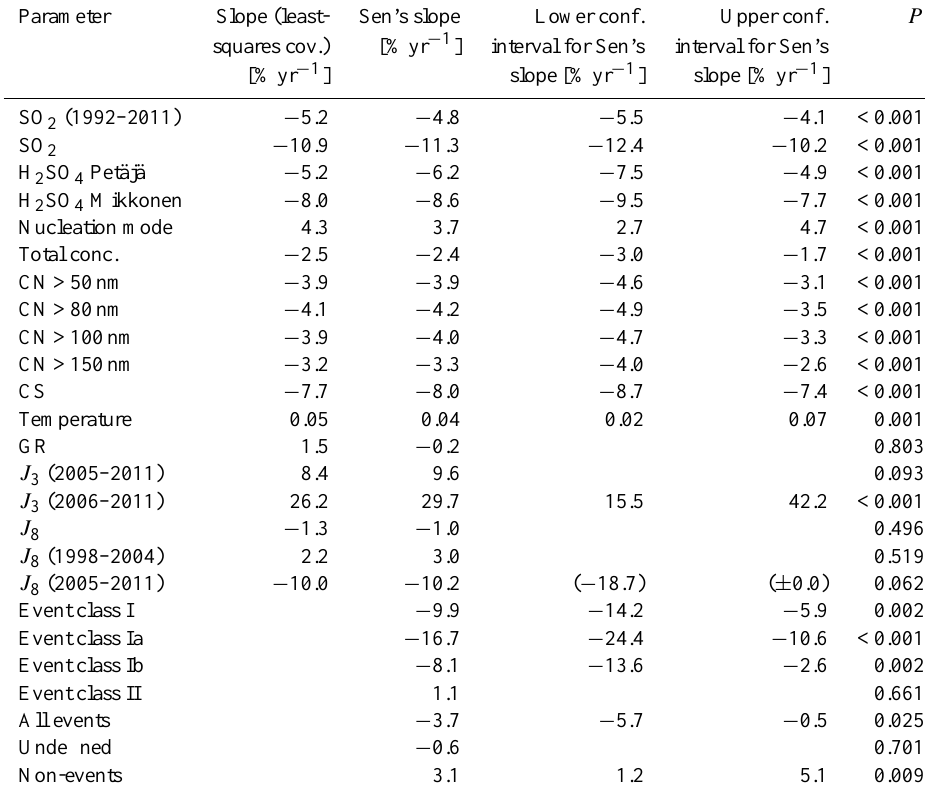
Table 2. Trends for various parameters obtained using both least-squares covariance method where the seasonal trend has been taken into account, as well as Mann–Kendall method (Sen’s slope) without seasonality, as percentages per year. The slopes are for years 1998–2011, unless mentioned otherwise. The lower and upper 95th confidence intervals for Sen’s slopes are given for significant trends ( P <0.05), except for J 8 (2005–2011) where the confidence intervals are given in parentheses, although P = 0.062. Parameter Slope (least- Sen’s slope Lower conf. Upper conf. P squares cov.) [%yr − 1 ] interval for